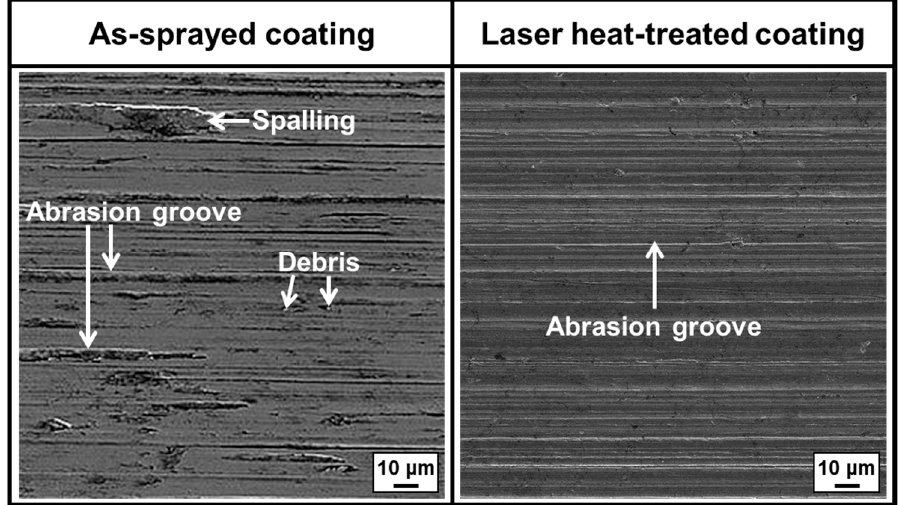
Figure 15. SEM image of the worn surface of an as-sprayed sample and the laser heat-treated sample at 1473 K after the tribotesting.